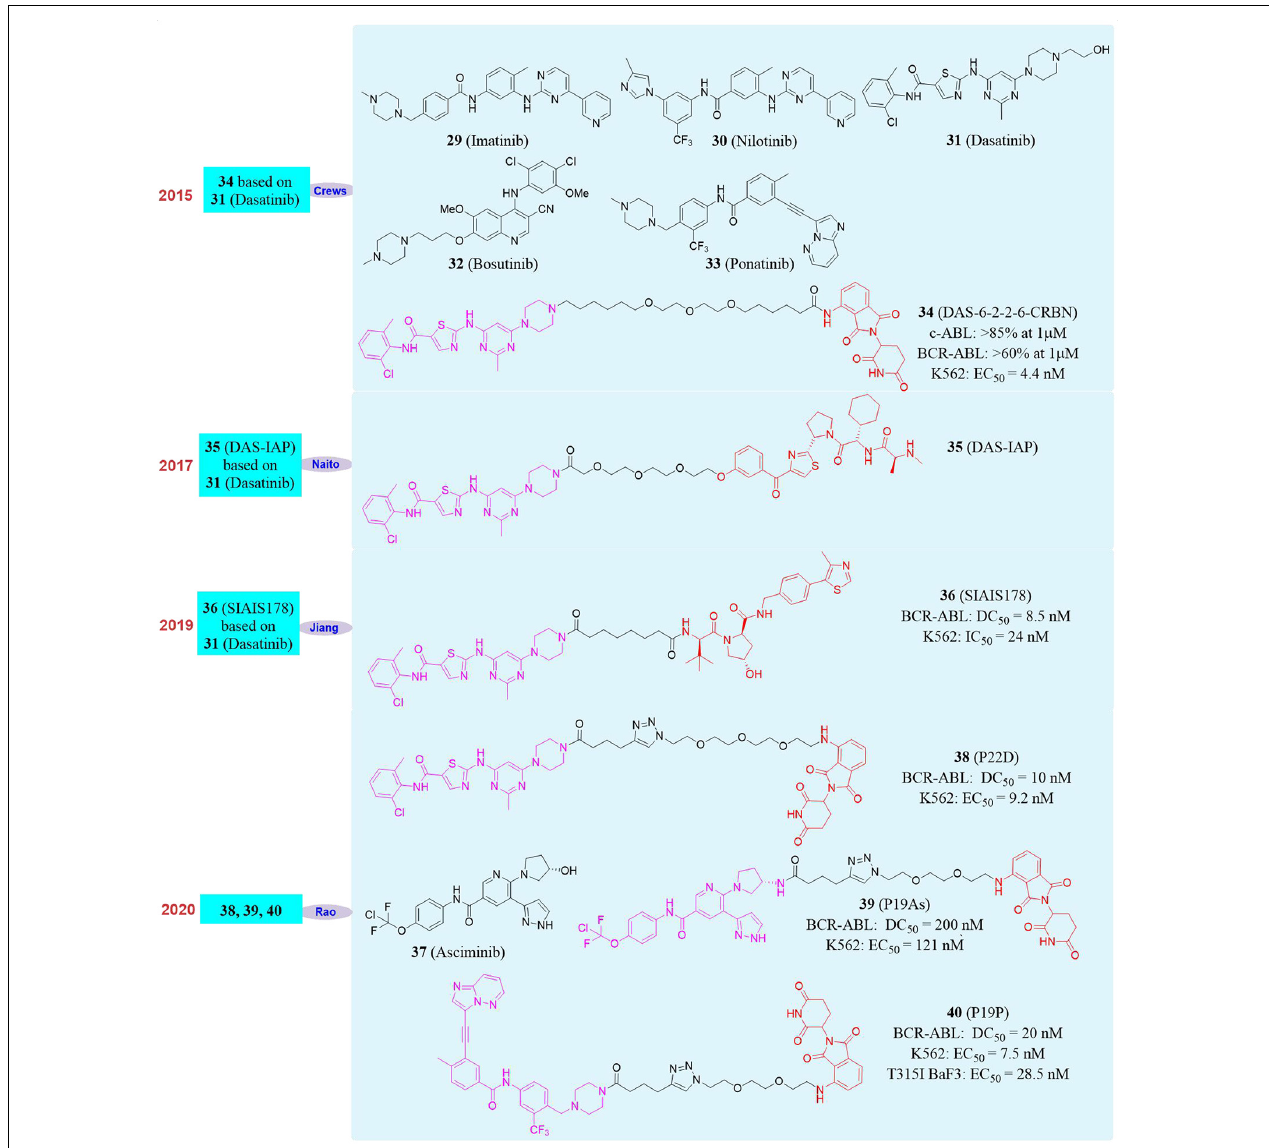
FIGURE 7 | Structures of BCR-ABL inhibitors and